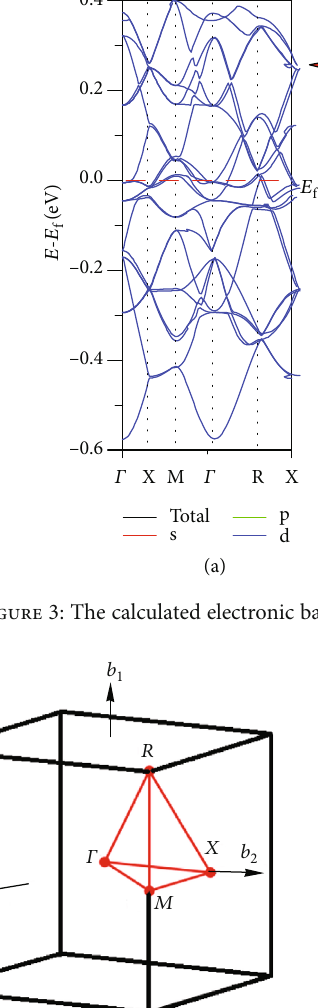
CUB path: 𝛤 - X - M - 𝛤 - R - Figure 4: The high symmetry k -path in the cubic fi rst Brillouin zone.